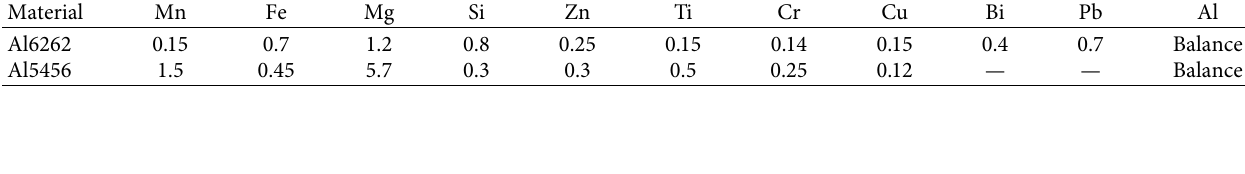
Table 2: Mechanical properties of Al6262 and Al5456.